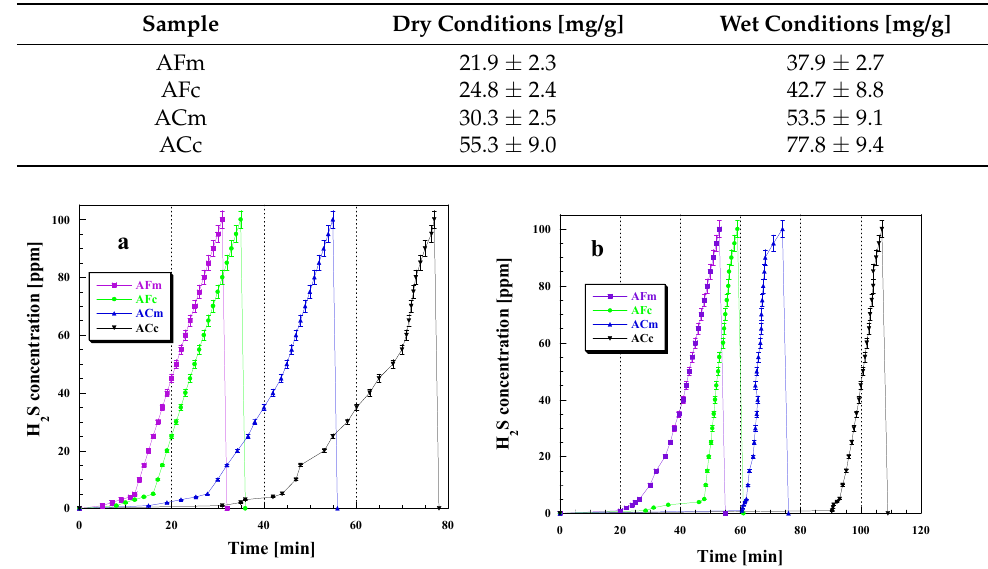
Table 8. H 2 S breakthrough capacities of the biocarbons obtained.